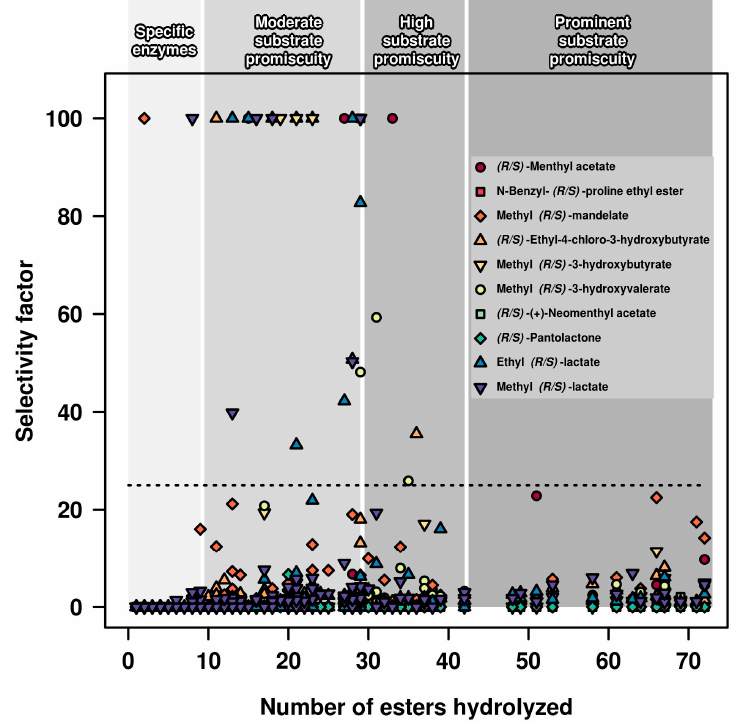
Figure 2. Chiral selectivity factor vs. number of esters hydrolyzed per each of the 145 hydrolases tested. Selectivity factor was calculated per each pair of enantiomers as the ratio of specific activity (U · g − 1 ) of the preferred over the non-preferred chiral ester when each of the chiral esters was tested separately. Chiral esters are color coded. The value 100 was arbitrarily given to represent those esterases capable of hydrolyzing, under our assay conditions, only one of the enantiomers (100% selective) and those with selectivity factors higher than 100. These data are based on the data reported previously [5], using conditions described in Materials and Methods. The level of promiscuity, according to criteria previously established [5], is marked under a shadowed grey background. The 25-selectivity factor threshold at which an esterase started to have commercial value is indicated by a horizontal dashed gray